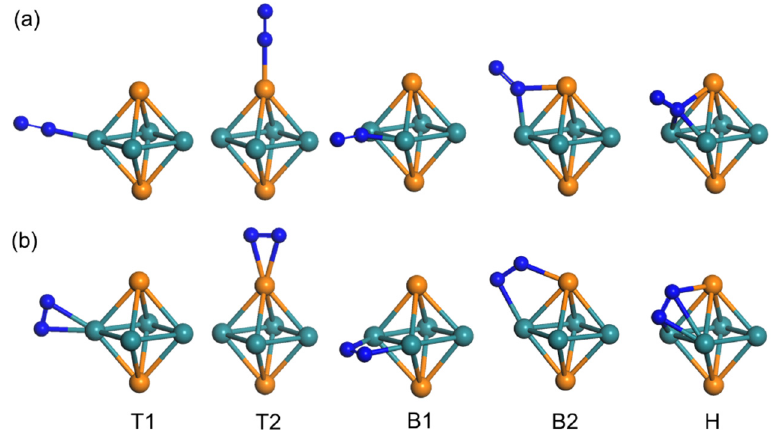
Figure 6. ( a ) End-on and ( b ) side-on configurations of N 2 adsorbed sites (T1, T2, B1, B2, H) on octahedral Ru 4 Rh 2 clusters. Green balls represent Ru atoms, orange balls represent Rh atoms, and blue balls represent N atoms. B2 site of side-on configuration has the longest N − N bond length. Table 2 . Adsorption energy E a (eV), bond length d (Å), vibrational wavenumbers ν (cm − 1 ) and total